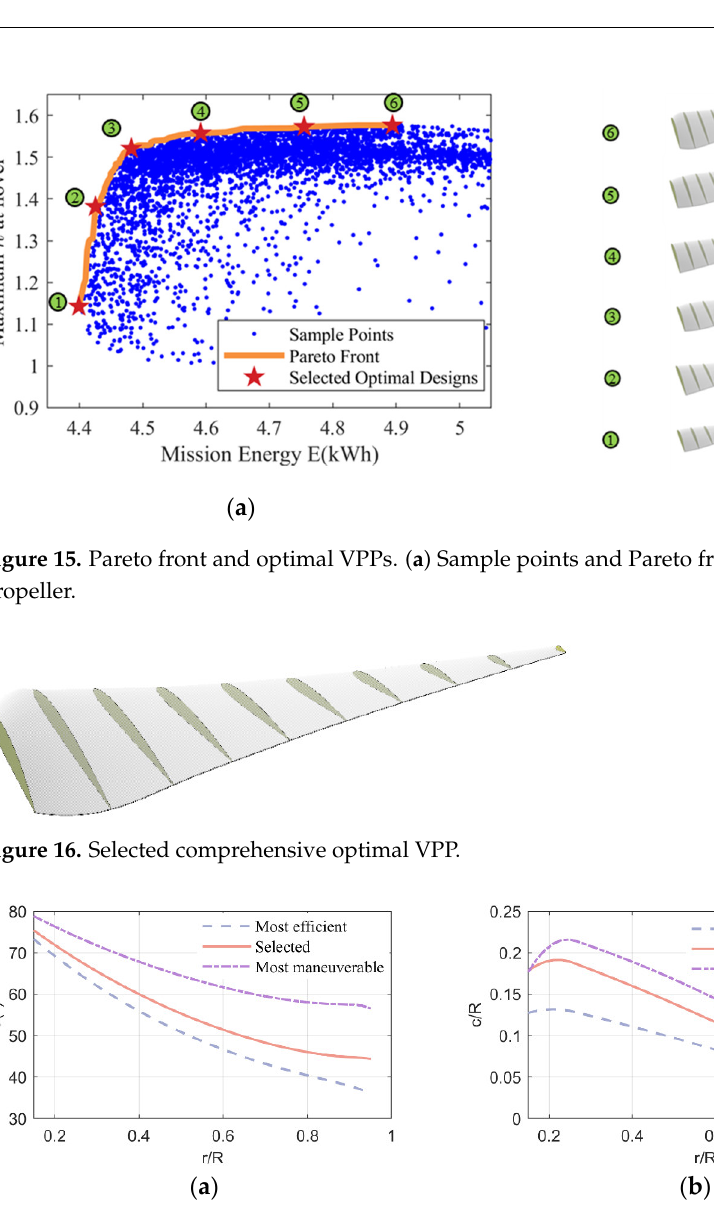
Figure 17. Twist angle and chord-length distribution of a comprehensive optimal VPP. ( a ) Twist angle distribution; ( b ) chord-length distribution.